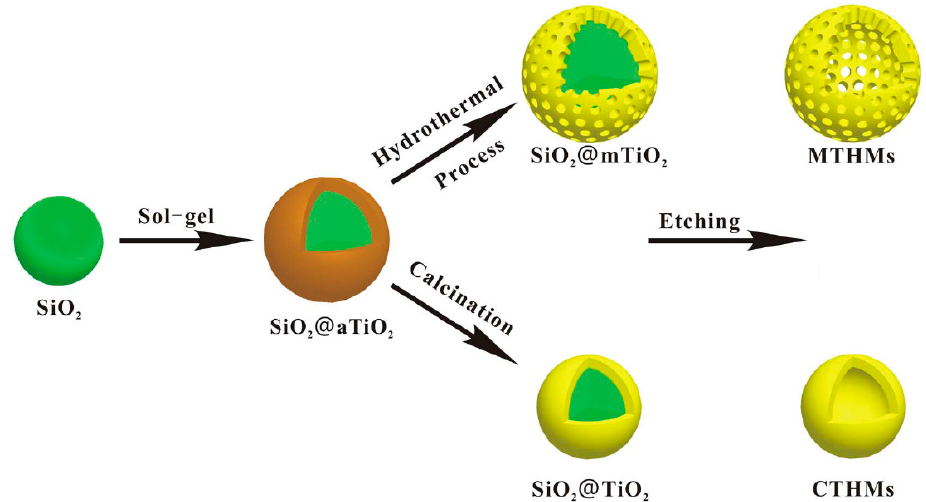
Figure 6. Schematic illustration of the process for the fabrication of the mesoporous TiO 2 hollow microspheres [39].